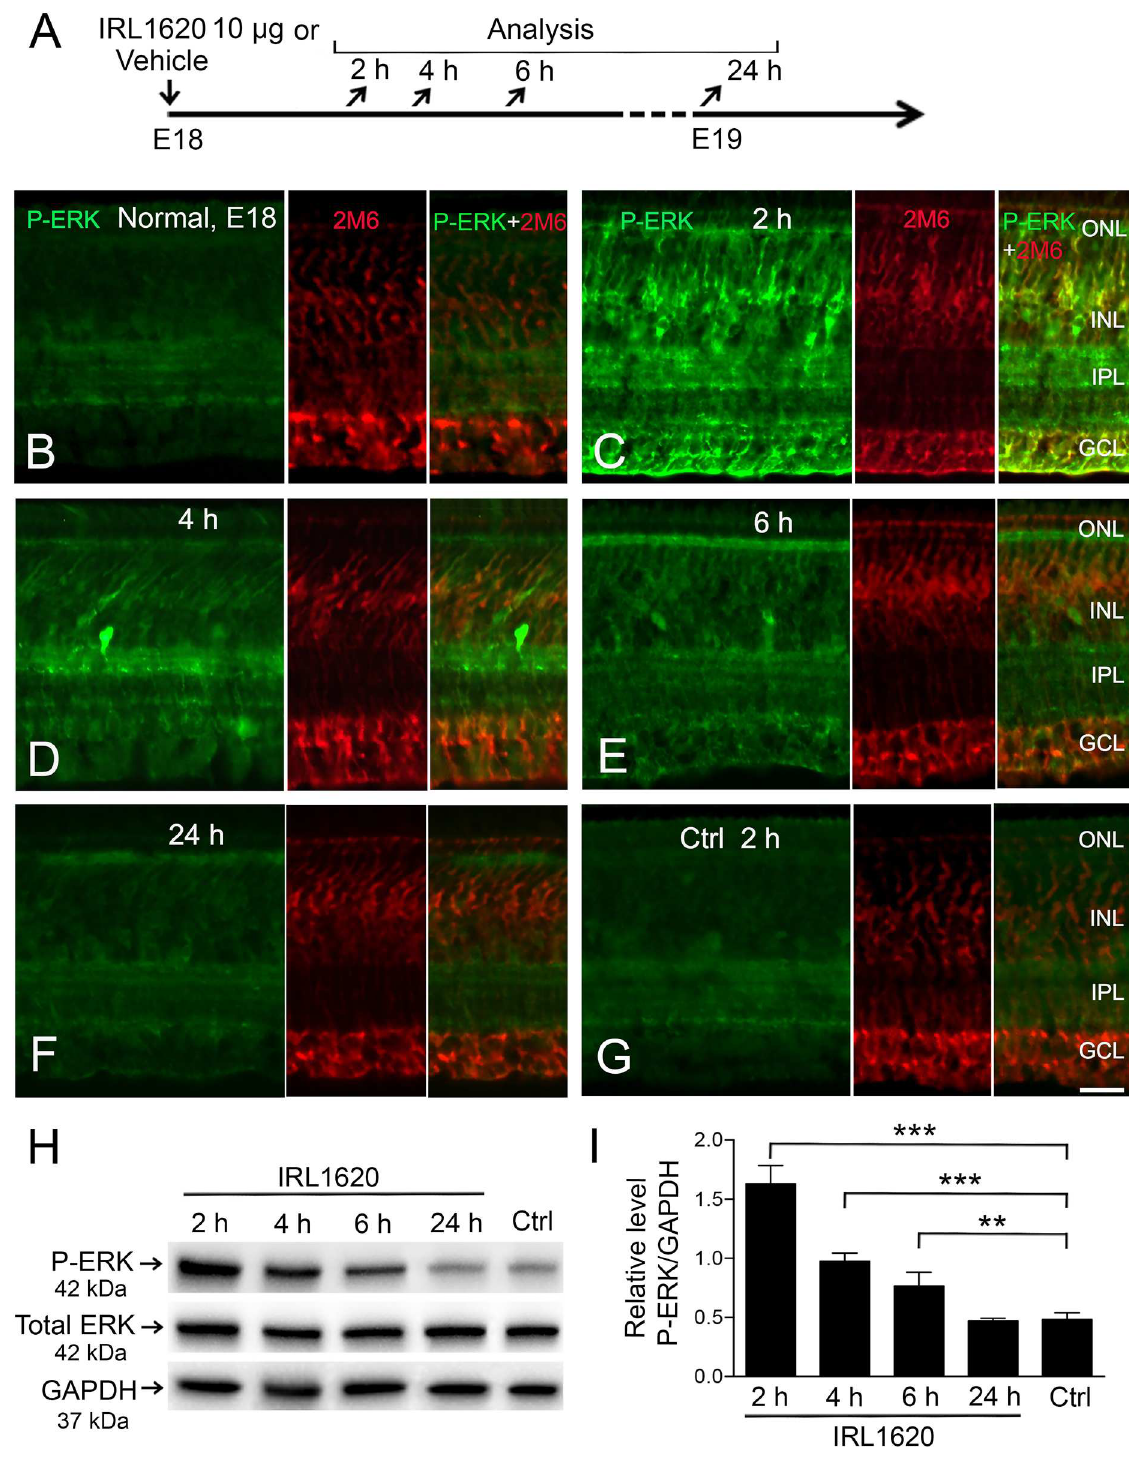
Fig 2. EDNRB agonist IRL1620 activatesP-ERK1/2 in chicken retina. Immunohistochemistry and western blot analysisof P-ERK after intra-ocularinjectionof IRL1620in E18 chicken embryo. (A) Experimental outline. (B–G) Fluorescence micrographs showingP-ERK and 2M6 (Mu¨ller cell marker) immunoreactivity in (B) normal untouched retina, retina after (C) 2 h, (D) 4 h, (E) 6 h, (F) 24 h IRL1620treatment. (G) Vehicle-injected eye at 2 h (Ctrl). (H) Representative western blot analysisof P-ERK in retina 2, 4, 6, and 24 h after IRL1620treatment. Note that western blot analysisfor ERK1/2 in chicken only shows one band in contrast to